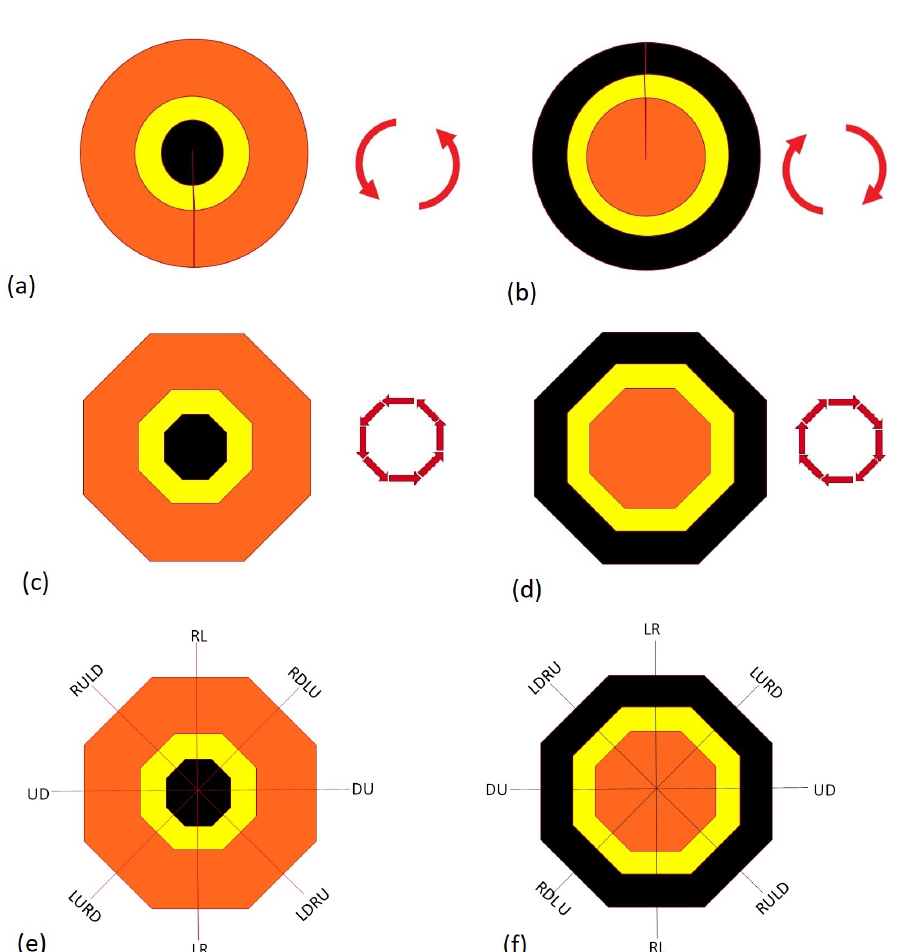
Figure 8. The complete circles of turns for a sample three-mode corridor for both counter-clockwise and clockwise turns are shown in subfigure ( a ) and subfigure ( b ), respectively. To keep the geometry simple these circles modeled by turning octagons shown in subfigure ( c ) and subfigure ( d ). Each turn is made of an input and an output moving neighborhood which specify the sector of each turn in the turning octagons. These sectors are shown in subfigure ( e ) and subfigure ( f ) for counter-clockwise and clockwise turns,